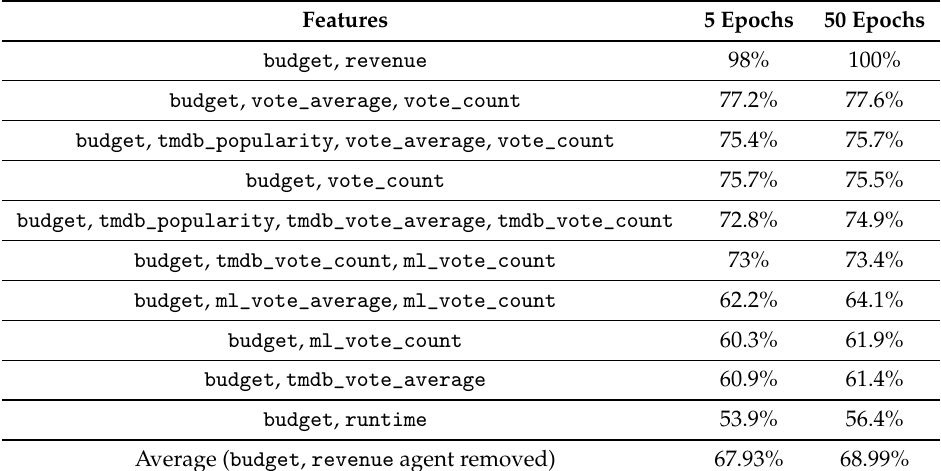
Table 3. Agent Classifier Accuracy for 5 and 50